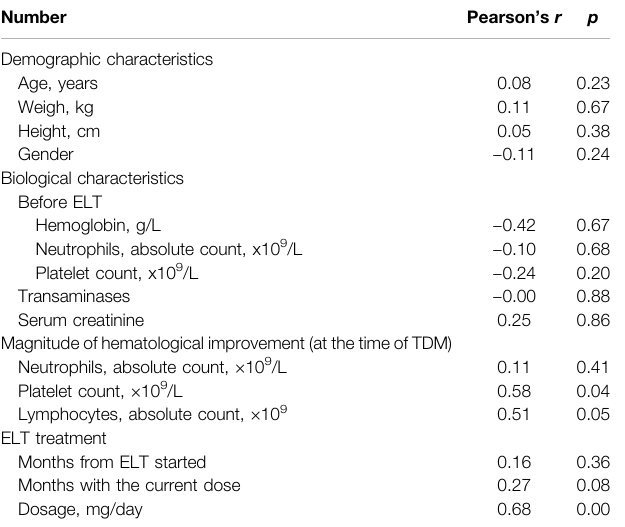
TABLE 2 | Correlations of clinical characteristics and plasma concentrations of ELT.